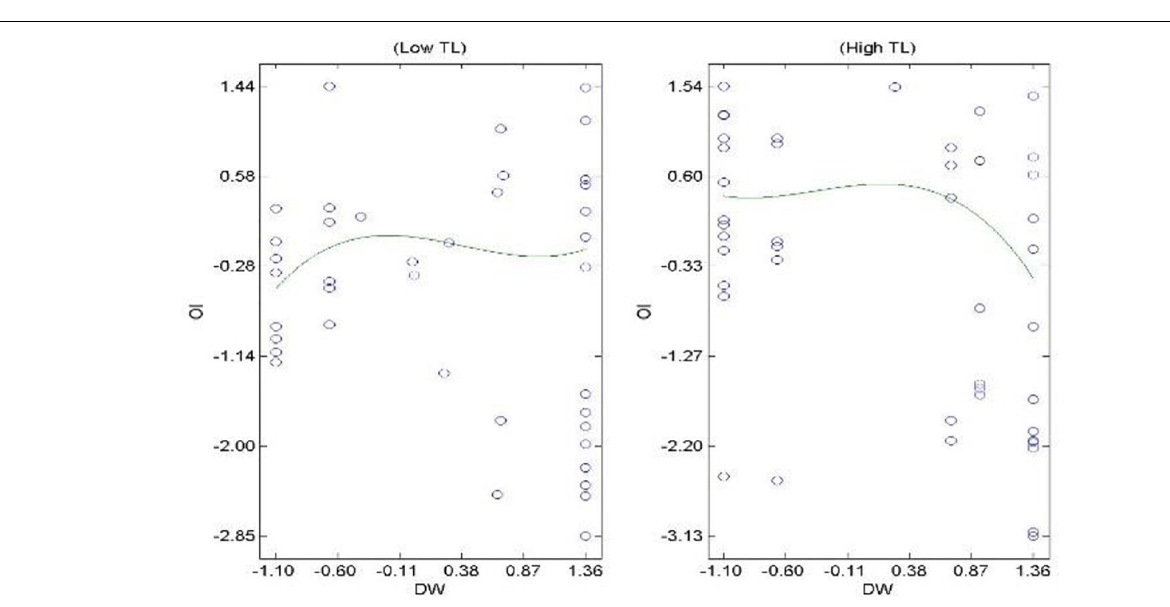
dimension of commitment that gets affected negatively as a result of downsizing the other two dimensions of commitment remain the same or even get